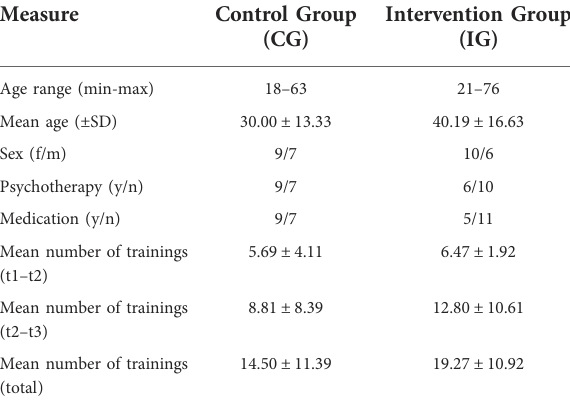
TABLE 2 Demographic and general